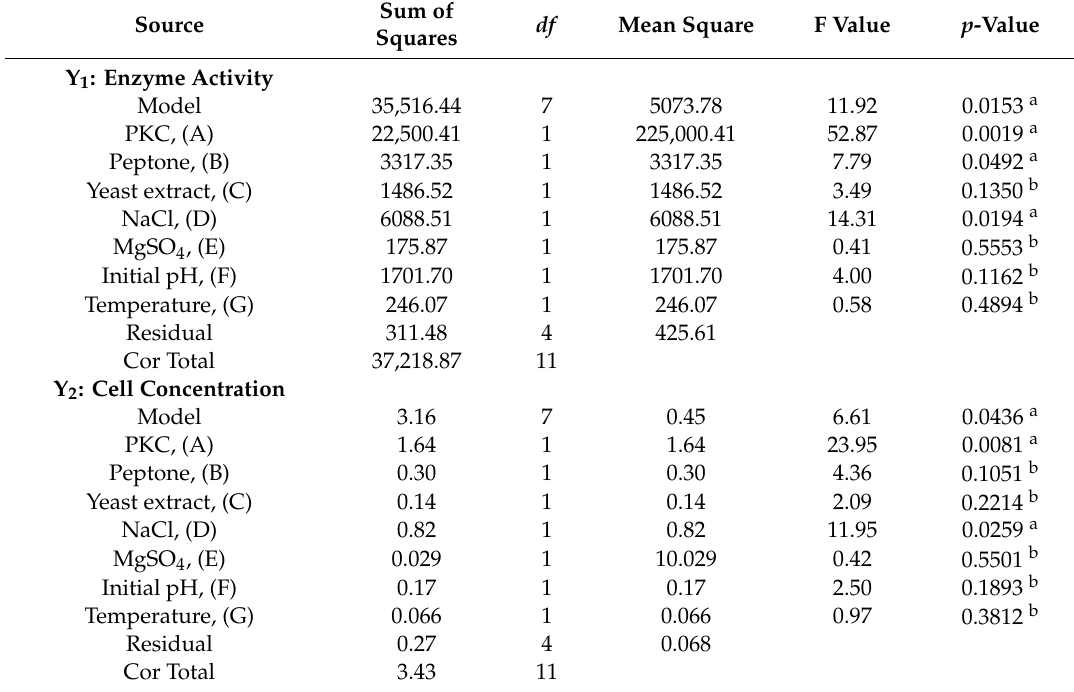
Table 3. ANOVA of Plackett-Burman screening design experiment for the production of β -mannanase. Sum of df Mean Square F Value p Source Squares